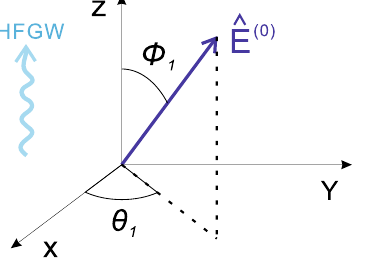
Fig. 1 The background stable electric field ˆ E ( 0 ) has an arbitrary direc- tion. Here the HFGW propagates along the z -direction